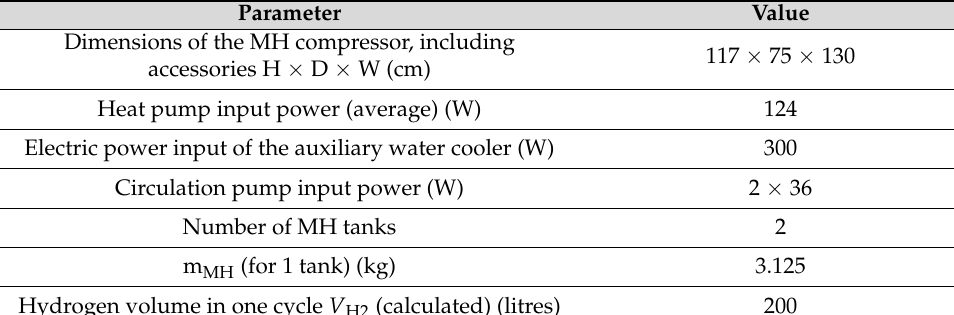
Table 1. Description of the basic parameters of the MH compressor. Parameter Value Dimensions of the MH compressor,